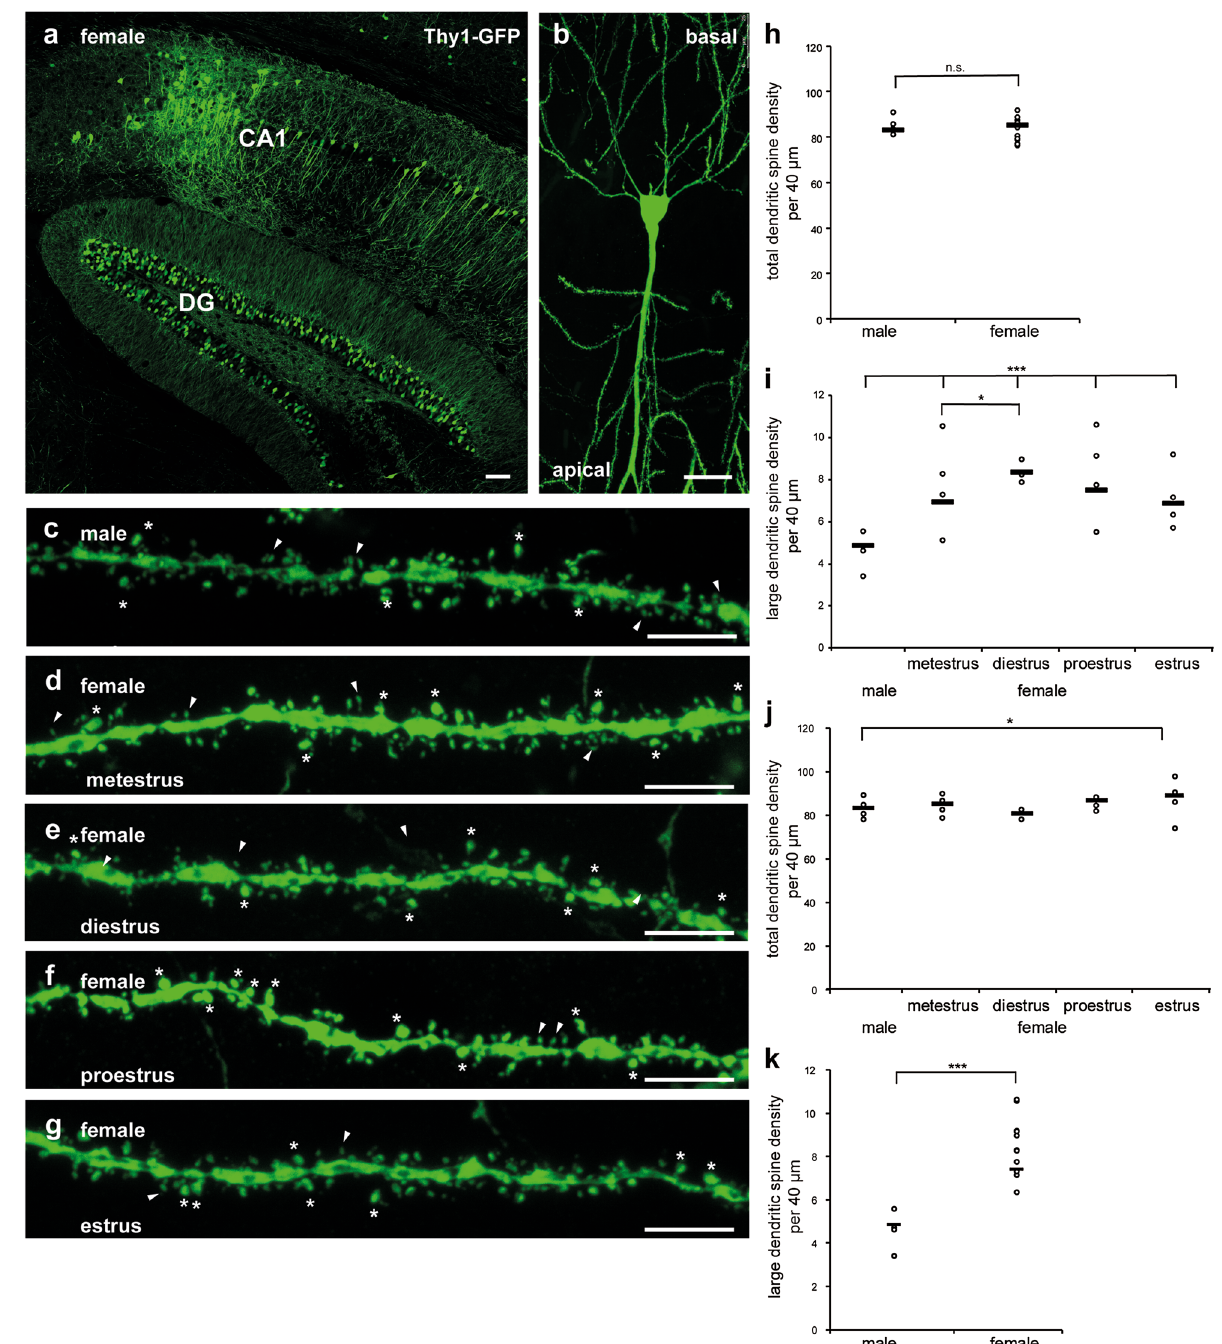
Figure 1. Hippocampal section of the Thy1-GFP mouse showing sparse expression of GFP in isolated pyramidal neurons and granule cells. Female hippocampal neurons display more large spines than male neurons in vibratome sections of hippocampal tissue. ( a ) A representative section (confocal stack) of adult female Thy1-GFP mouse hippocampus was stained with an antibody to GFP to enhance the GFP immunolabeling and visualize the morphology. Scale bar represents 75 µm. Abbreviations: CA1 (cornu ammonis), DG (dentate gyrus). ( b ) Representative example of a female pyramidal neuron (confocal stack) from the hippocampal CA1 region expressing a genetically encoded GFP, allowing for analyzing spine morphology in vibratome sections of hippocampal tissue. Scale bar represents 25 µm. Confocal image (stack) of a ( c ) male, ( d ) female metestrus, ( e ) female diestrus, ( f ) female proestrus and a ( g ) female estrus CA1 hippocampal dendrite with large (indicated with asterisks) and other (indicated with arrow heads) spines are shown. At this magnification individual spines can readily be classified. Scale bar represents 5 µm. ( h ) Histogram showing the total apical dendritic spine density after three-dimensional reconstruction of male and female neurons. In the scatterplot “ − ” indicates the mean. Quantification of spine densities in hippocampal sections of EGFP-Thy1 mice reveals no difference in total apical spine number (p = 0.245; mixed model analysis; K–S test; n = 4 animals per male and n = 4 per